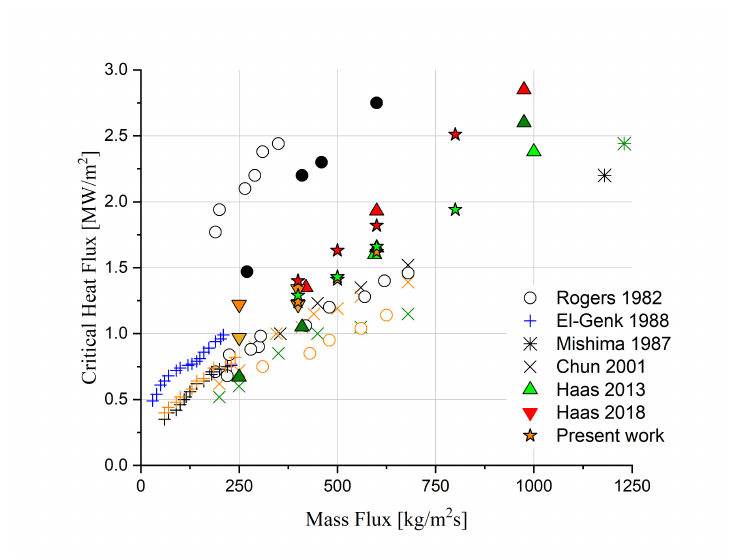
Figure 11. Comparison of CHF results from literature data [9,20] and the MRCHA facility results with description in Table